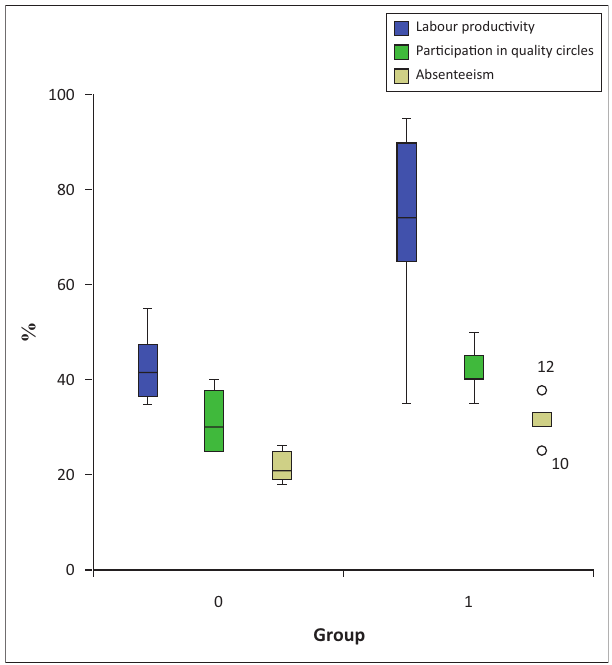
FIGURE 2: Box plots determining the normality and homogeneity of